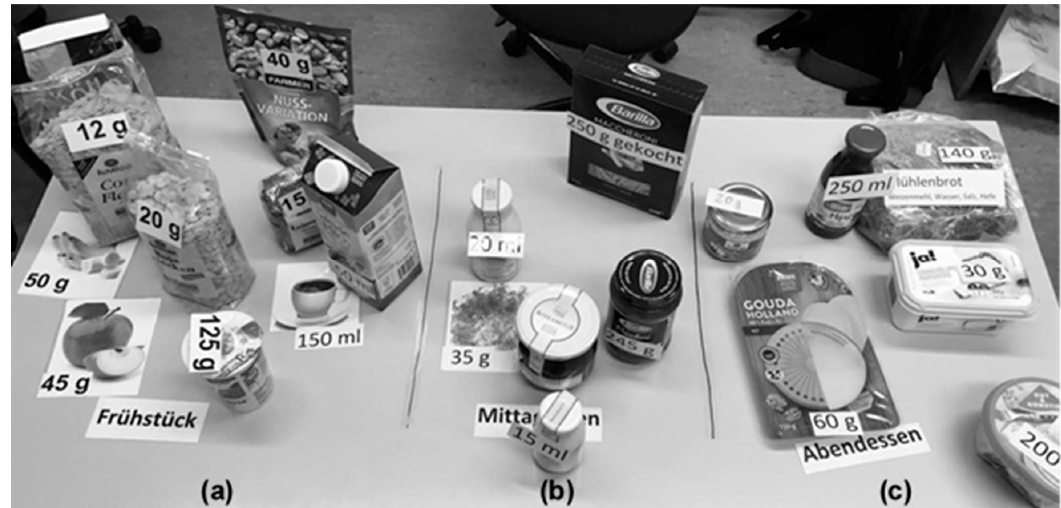
Figure 1. Sample meals presented to study participants. ( a ) Breakfast consisted of n = 10 food items ( n = 3 generic/ n = 7 branded; n = 3 in the database/ n = 7 not specifically in the database), ( b ) lunch consisted of n = 6 food items ( n = 1 generic/ n = 5 branded; n = 3 in the database/ n = 3 not